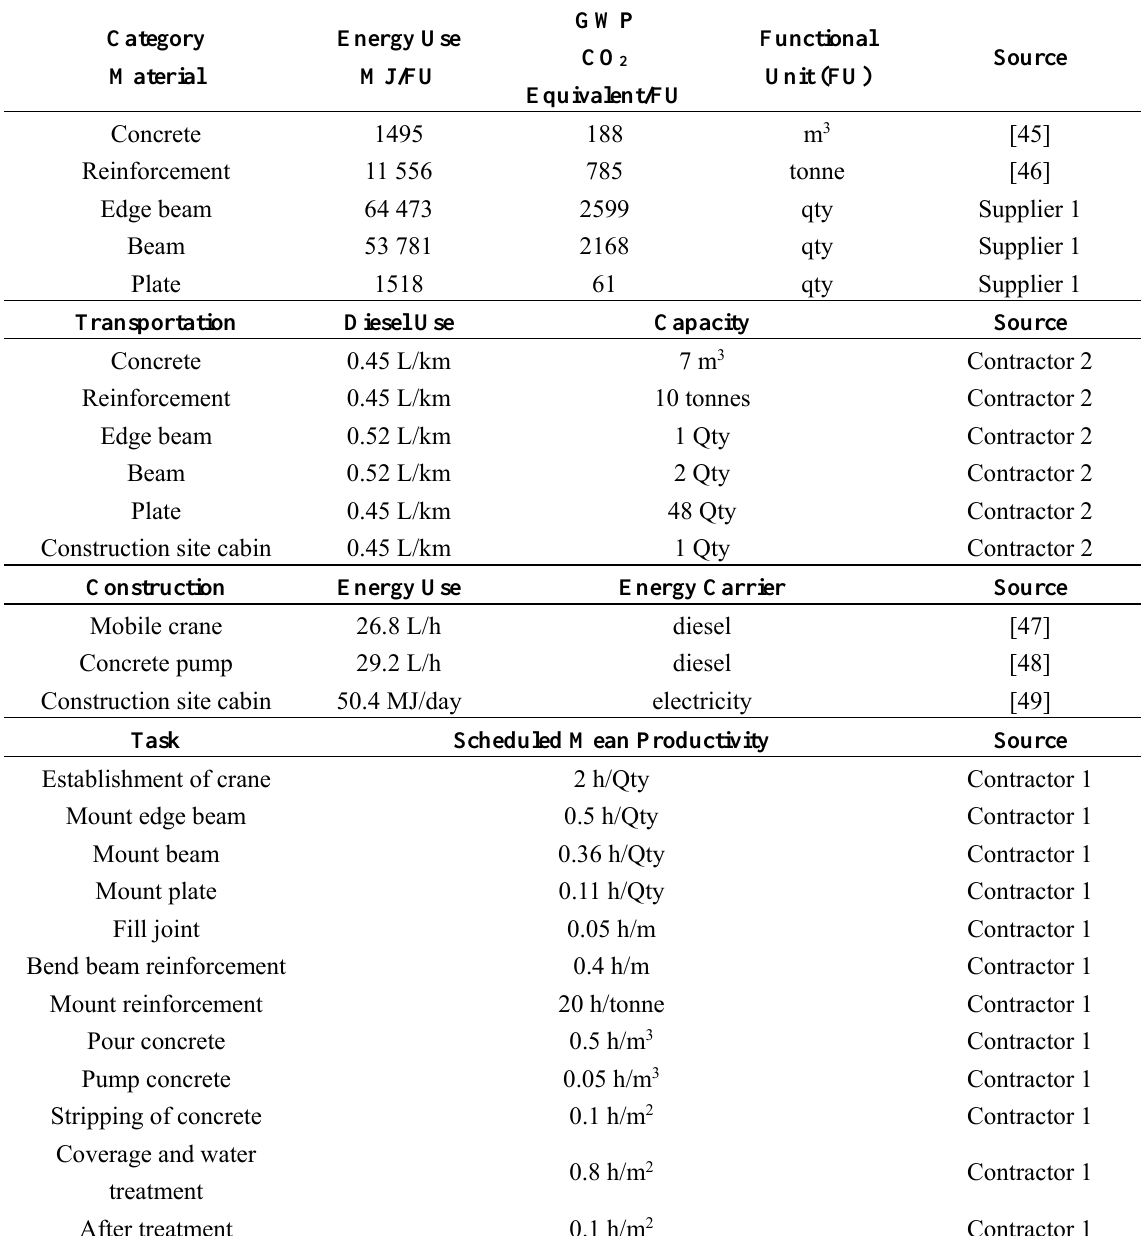
Table 2. General data added to the